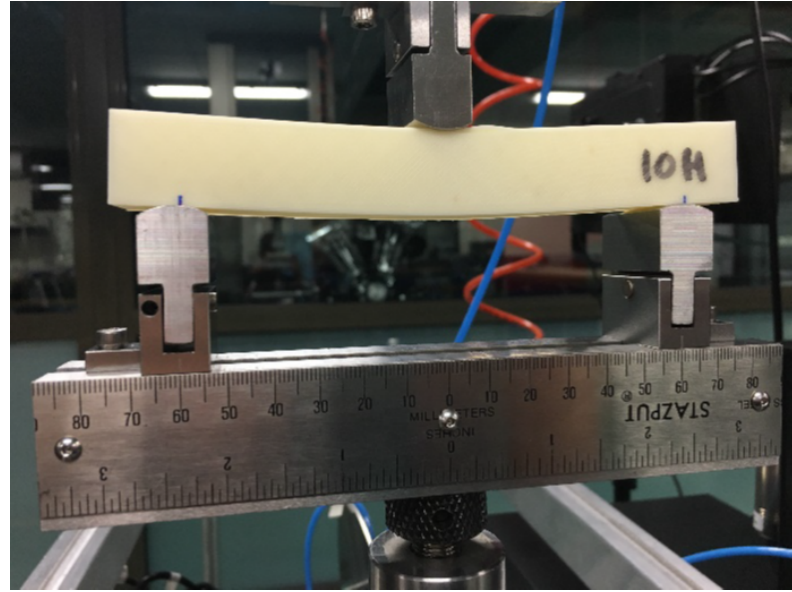
Figure 5. Bending test setting.